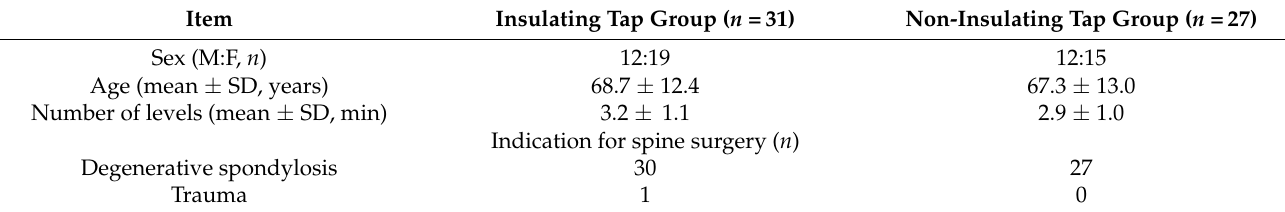
Figure 1. Newly developed insulated coated tap device was used in this study.